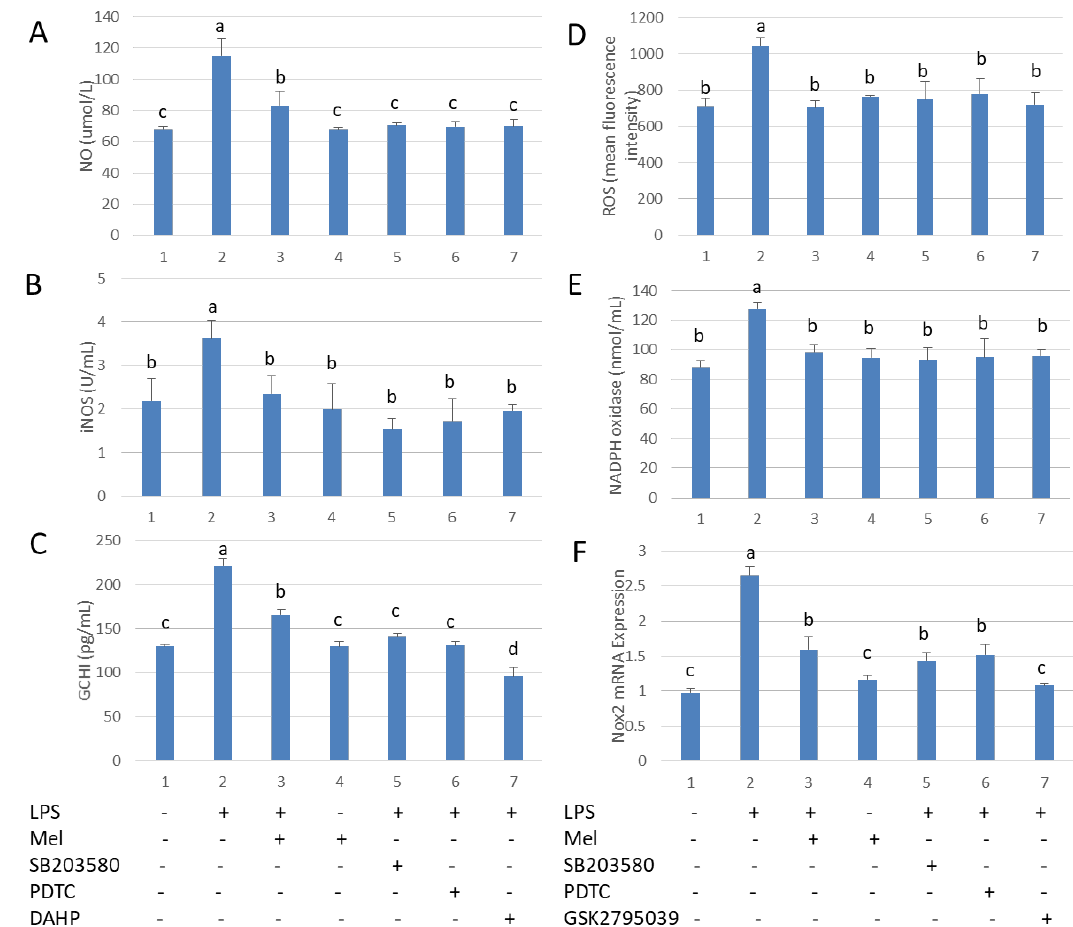
Figure 4. Melatonin reduces GCH1 activity and Nox2 mRNA expression in LPS-stimulated testicular macrophages. ( A ) NO content. ( B ) iNOS activation. ( C ) ELISA detection of GCH1 protein expression. TM treated with LPS, Mel, PDTC, DAHP and / or SB203580. ( D ) Flow cytometry analysis of ROS content. ( E ) NADPH oxidase activation. ( F ) mRNA expression of Nox2. TM treated with LPS, Mel, PDTC, GSK2795039 and / or SB203580. Data are shown as mean ± SEM. Di ff erent superscript letters (a–d) in each column representative statistically significant di ff erences ( p <